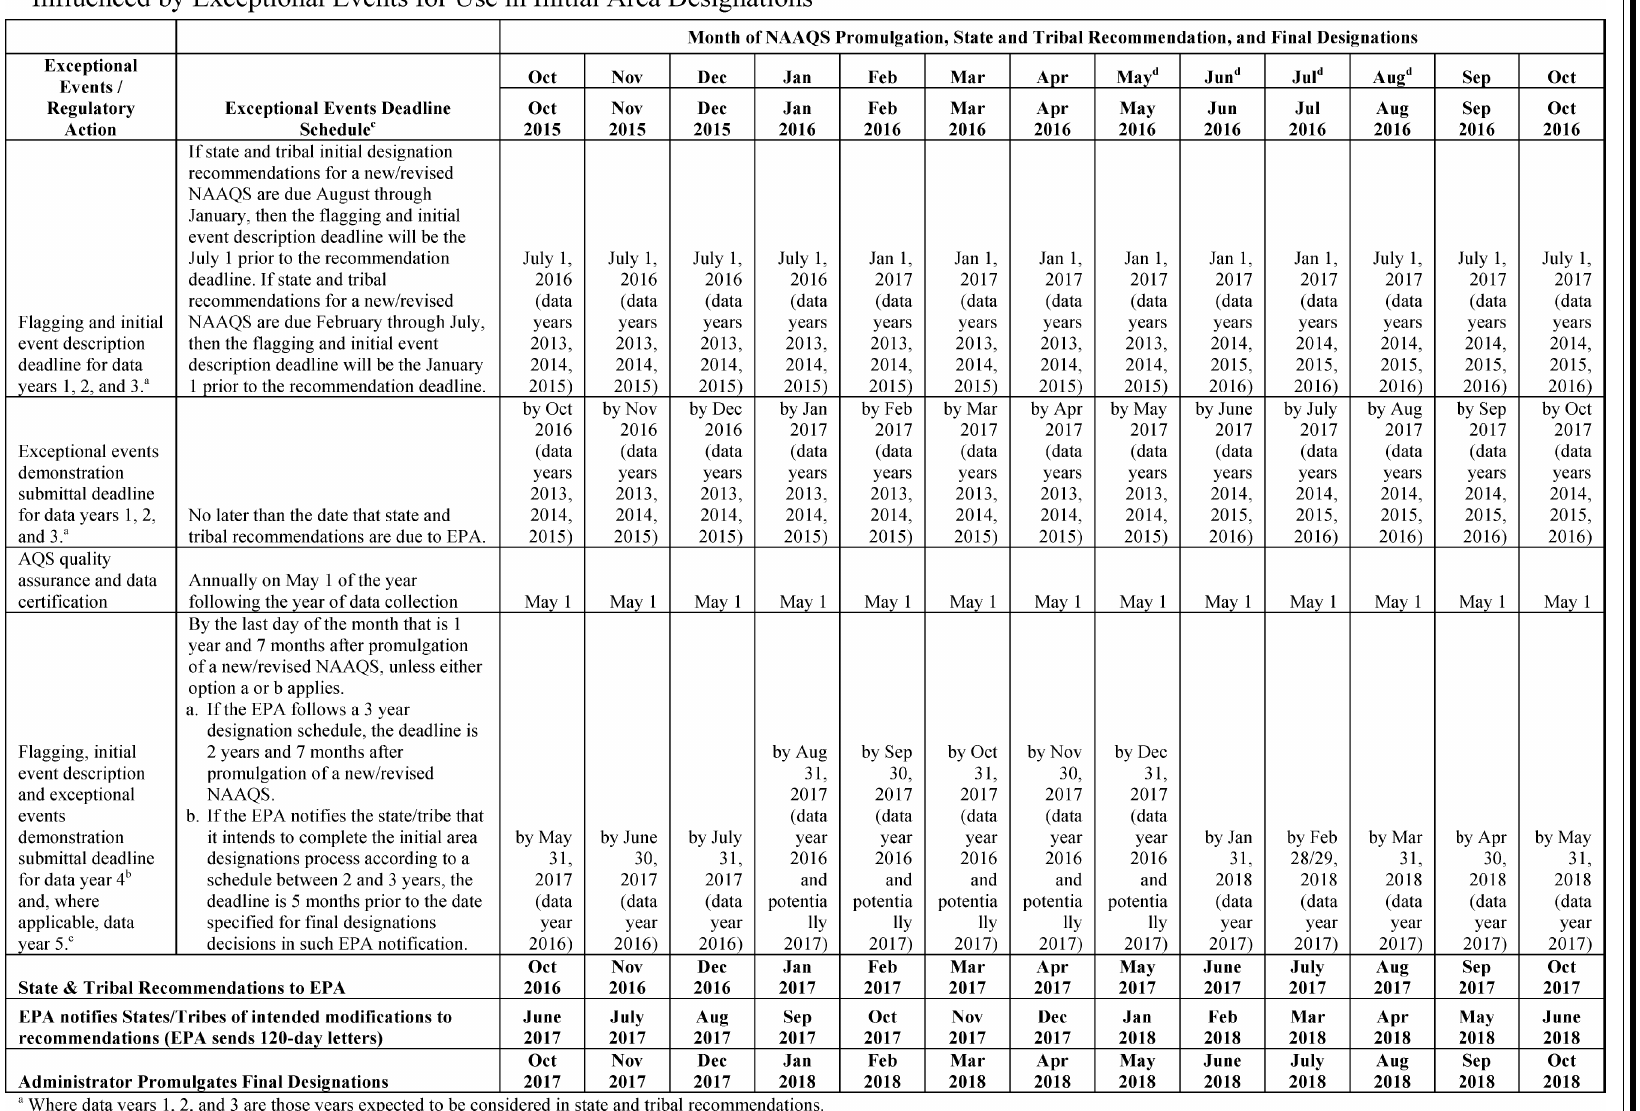
Month ofNAAQS Promulgation, State and Tribal Recommendation, and Final Designations